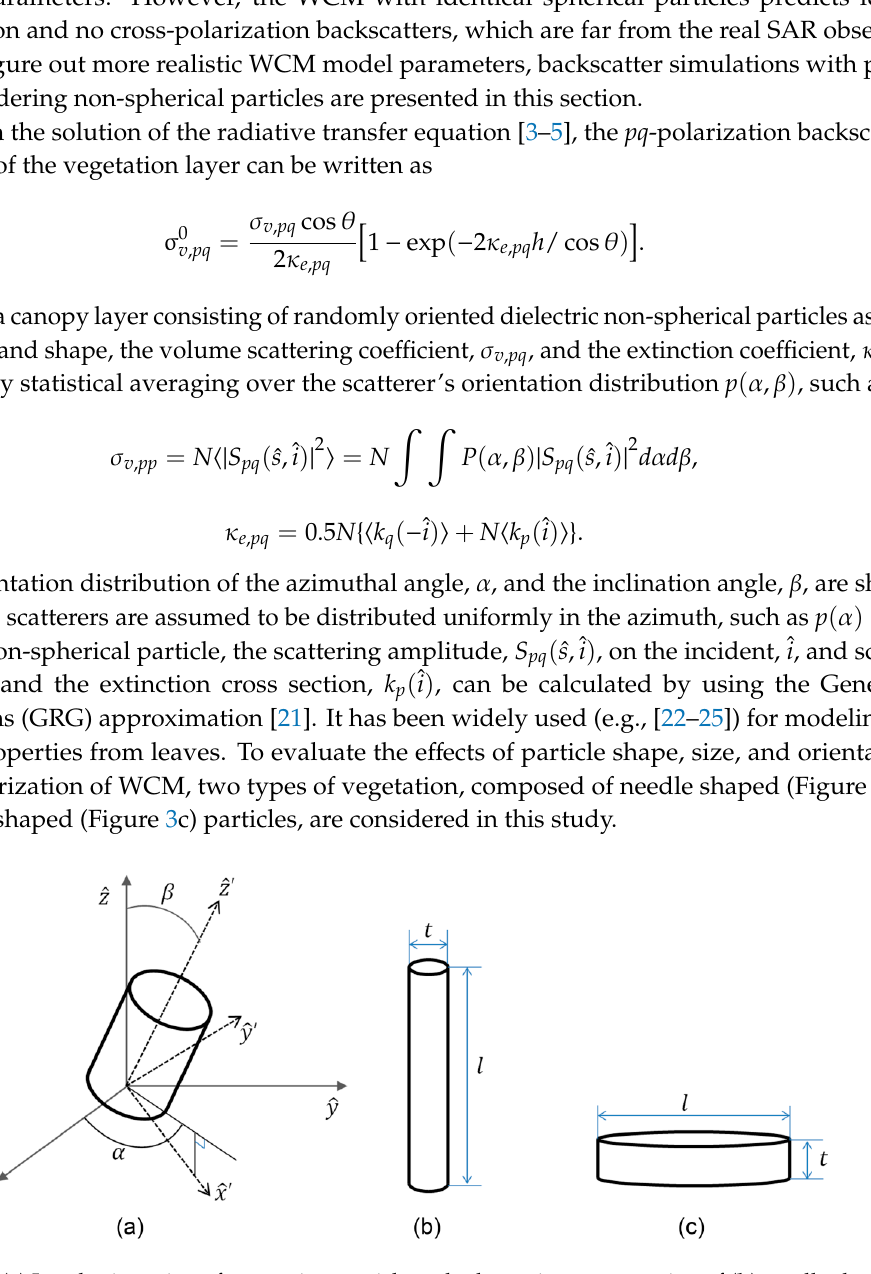
Figure 3. ( a ) Local orientation of vegetation particle and schematic representation of ( b ) needle shaped and ( c ) disk shaped particles, where 𝑡 and 𝑙 denote the thickness and length of the